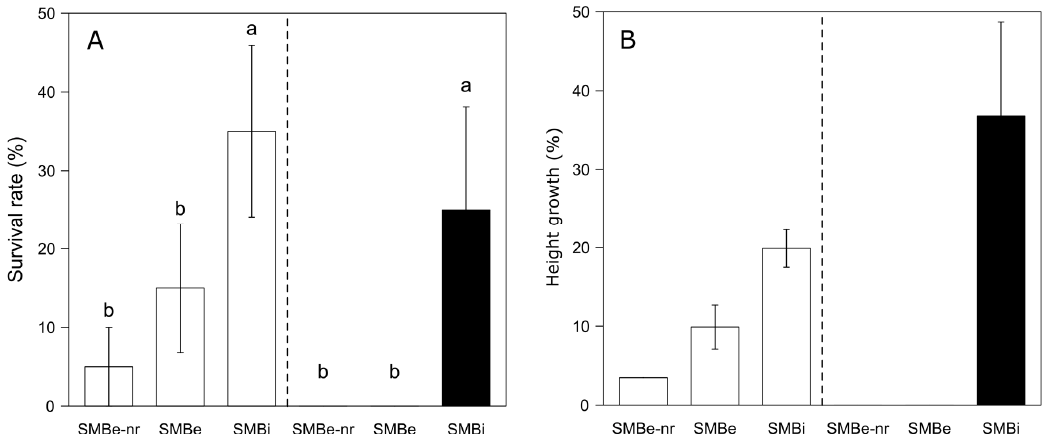
Figure 1. Survival rates ( A ) and relative height growth ( B ) of the sugar maple seedlings planted in the natural soil (white bars left of dashed lines) and in the pots filled with an enriched soil mixture (black bars right of dashed lines). Relative height growth is calculated as a percentage of pre-planting height. Different letters between forest types indicate a statistically significant difference at p < 0.05.